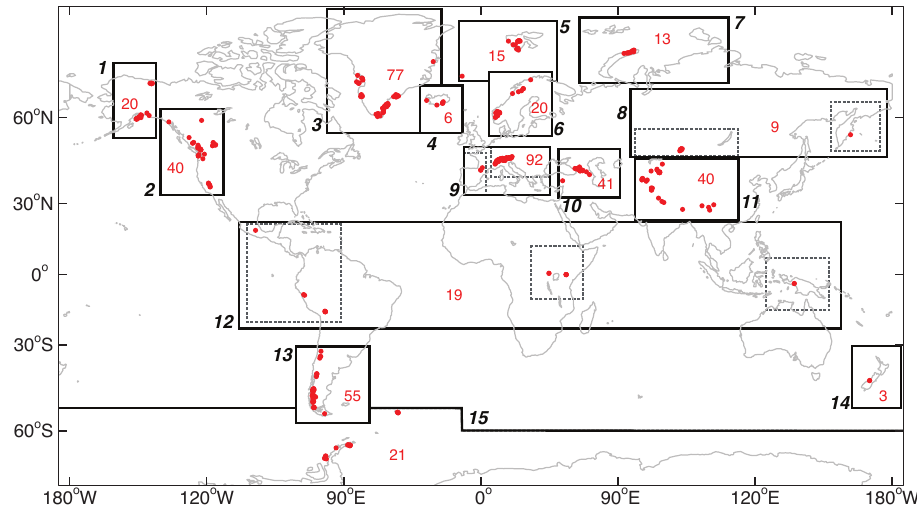
Fig. 2. Distribution of records over the world. In many cases the distance between the glaciers is so small that the dots overlap. The black boxes indicate the 15 first-order RGI regions, which in some cases are combinations of the regions defined in the data set (dashed grey boxes). The number inside the box (red) gives the number of records in the region, the number (italic, black) outside the box gives the number of the region (cf. Figs. 7, 9, Table 1). Table 1. Characteristics of the glacier length records per region. The numbers of the regions correspond to the numbers in Fig. 2. It shows: the total number of length records in the region (No. records); the regional average number of data points per record (data points per record); the glacier area covered by the glaciers in the data set (area (km 2 )), including the area as percentage of the total glacier area in the region given by the RGI (%total) and percentage of tidewater glacier area in the data set (%TW); the average year of the first data point (start year), with the range of years in which the records start; the year the records of the region on average end (end year), again with the range; and the average regional length change (average (km)), with its standard deviation (SD (km)), and range (range (km)) over the period 1901–2000 ( 1L 20th century). The standard deviation and range in the 20th century is only given for the glaciers that have data for the entire period 1901–2000.